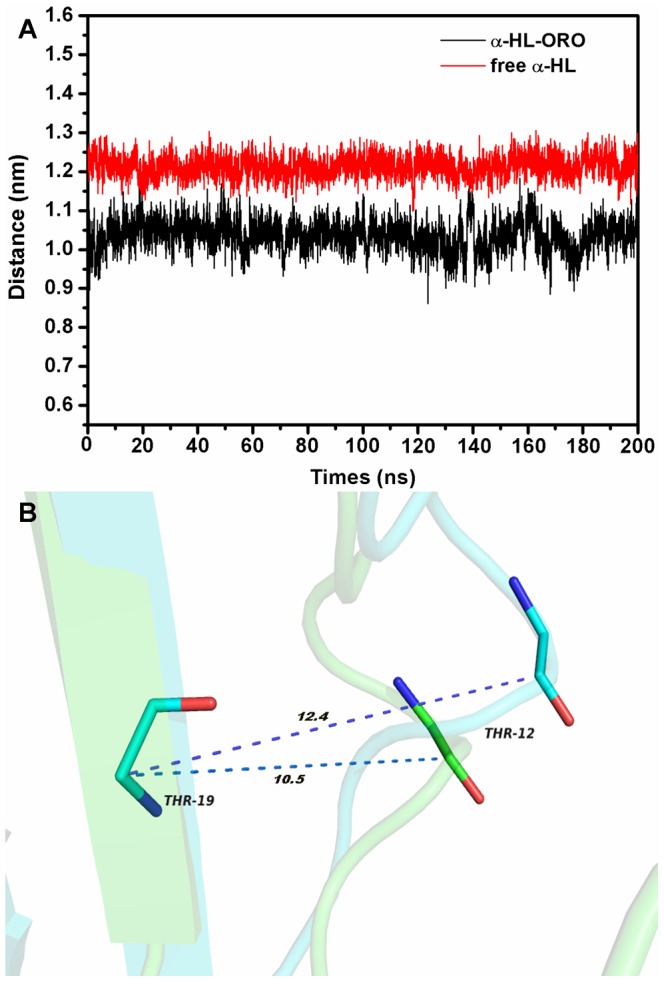
Comparison of the distance between the Cα atoms of Thr12 and Thr19 in different systems.(A) The distance between the Cα atoms of Thr12 and Thr19 as a function of time. (B) The distances between the Cα atoms of Thr12 and Thr19 is shown in the superimposition of the structures of free α-HL (blue) and the α-HL-ORO complex (green). The average distance in the complex and in the free protein is 1.05 nm and 1.24 nm, respectively.